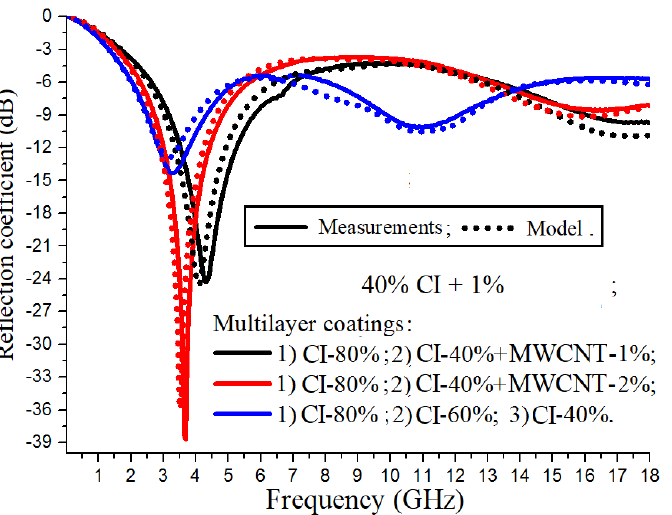
Fig. 6. Frequency dependence of the reflection coefficient from multilayer coatings with different concentrations of carbonyl iron and multi-walled carbon